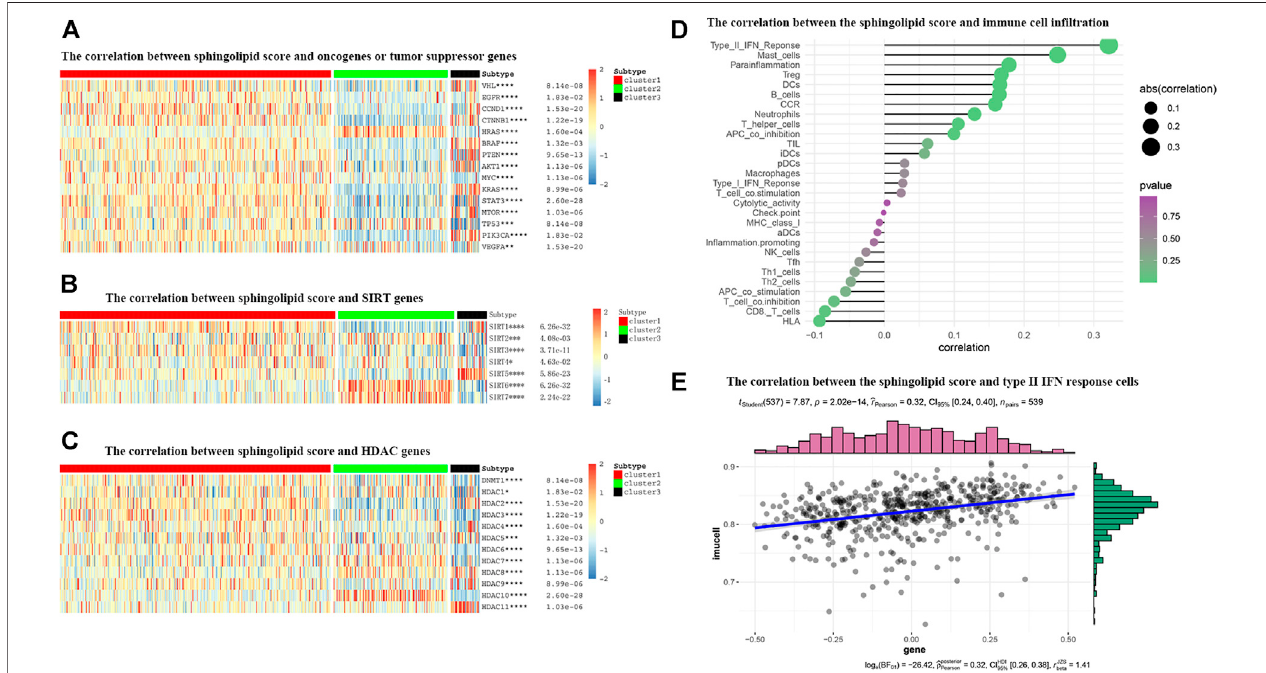
FIGURE 9 | The correlations between the sphingolipid score and the classical cancer-related genes or immune cell in fi ltration. (A – C) The heatmap shows the sphingolipid score is associated with other signaling pathways in KIRC. (A) The interrelation with oncogenes and tumor suppressor genes. (B) The interrelation with sirtuin family genes. (C) The interrelation with histone deacetylase (HDAC) family genes. The statistical method used in (A – C) is “ ANOVA ” (* p < 0.05, ** p < 0.01, *** p < 0.005,and**** p < 0.001). (D) Theplotshowsthecorrelationbetweenthesphingolipidscoreandimmunecellin fi ltration.Ontherightsideoftheplot,theareaofthe sphere represents the degree of abs (correlation) and the color indicates the p -value. (E) The scatter diagram shows the correlation between the sphingolipid score and type II IFN response cells. The sphingolipid score is positively correlated with the in fi ltration of type II IFN response cells.